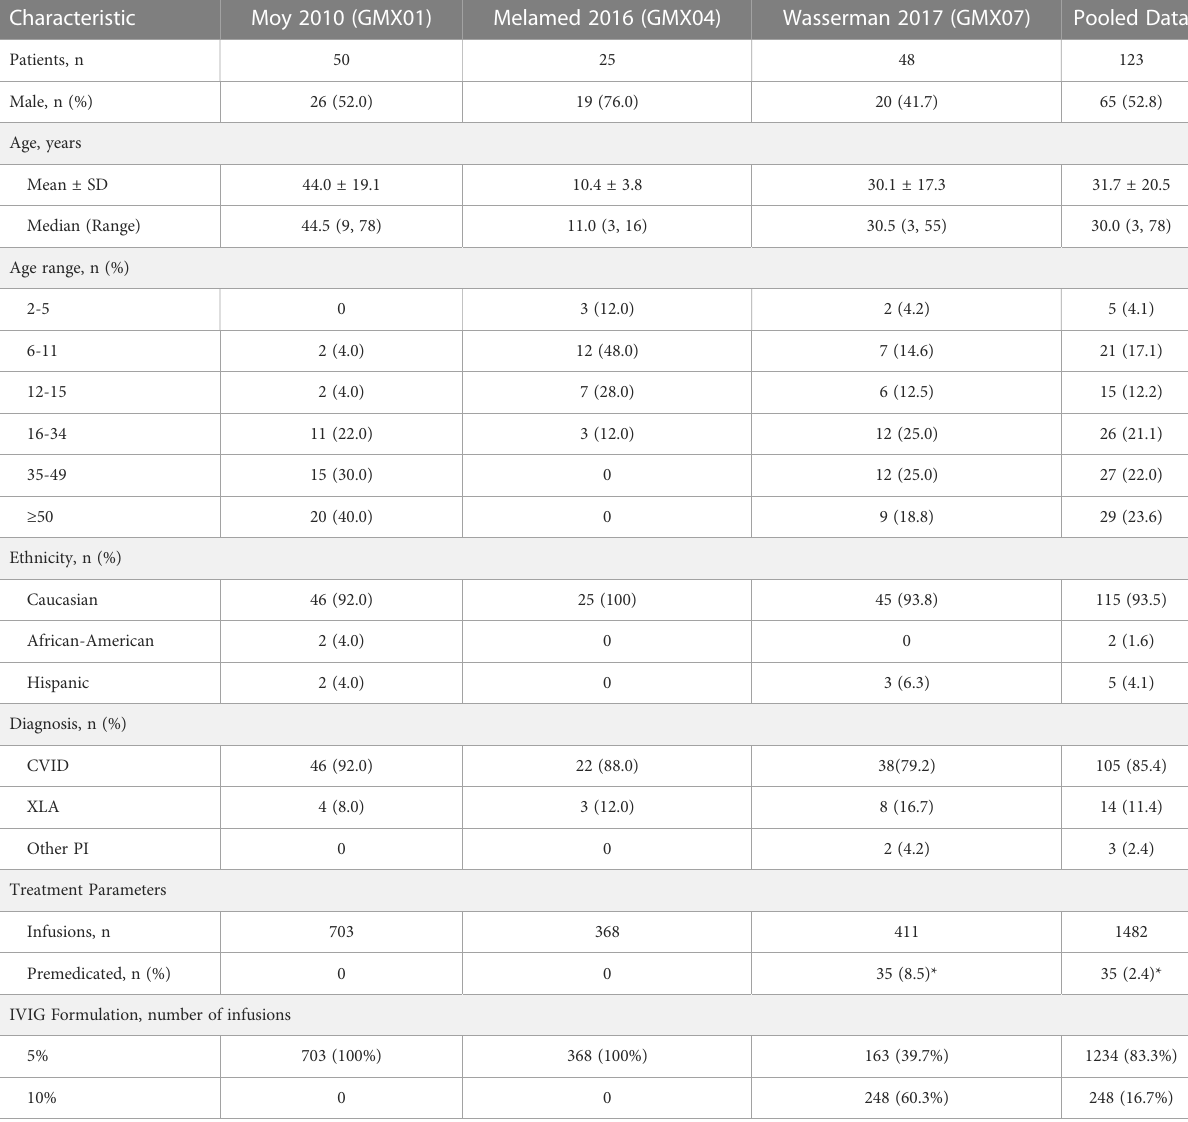
TABLE 3 Patient Demographics, Disease Characteristics, and Infusion Parameters (18 –